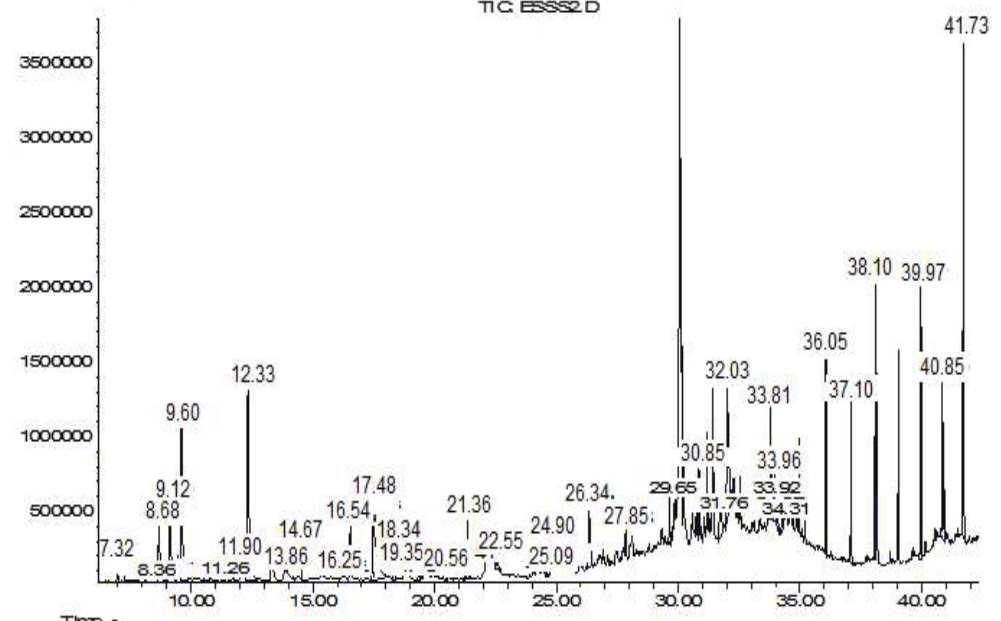
Fig. 3. Gas chromatogram of the components of the essential oil of leaves Crataegus monogyna